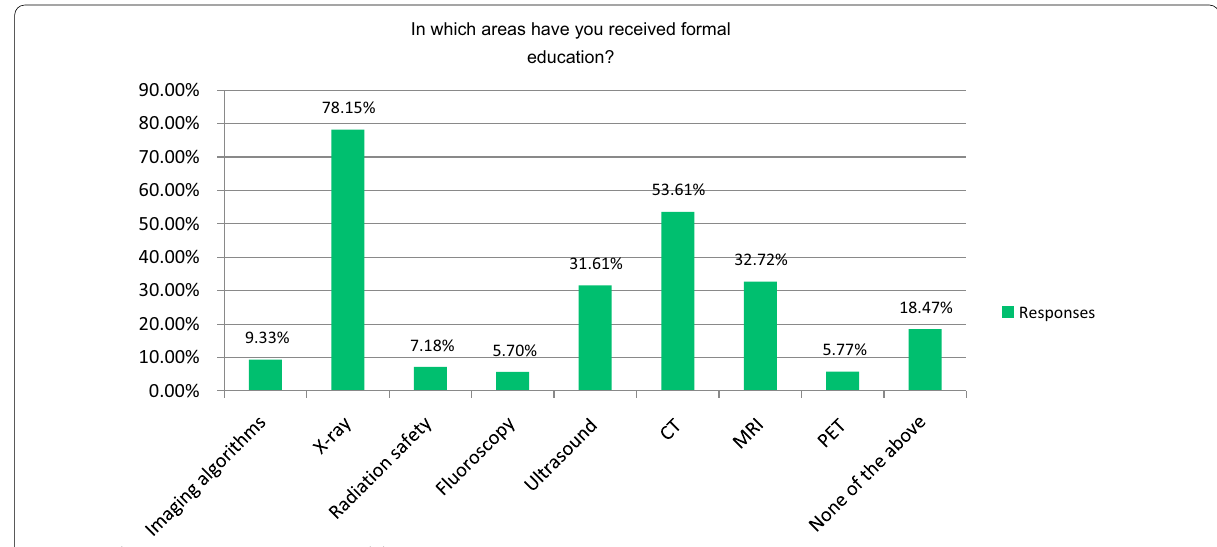
Fig. 2 Student’s exposure to imaging